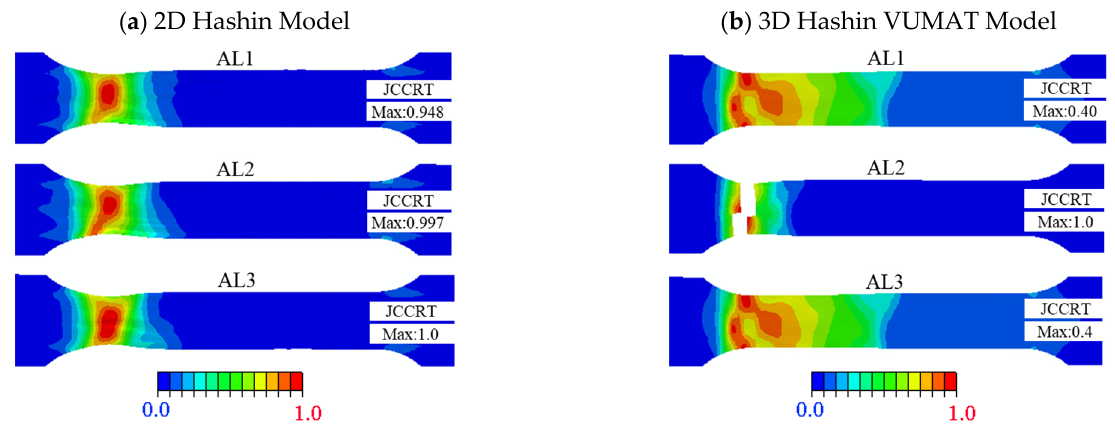
Figure 13. Failure cloud diagram of the aluminium alloy specimen: ( a ) 2D Hashin model; ( b ) 3D Hashin VUMAT model.